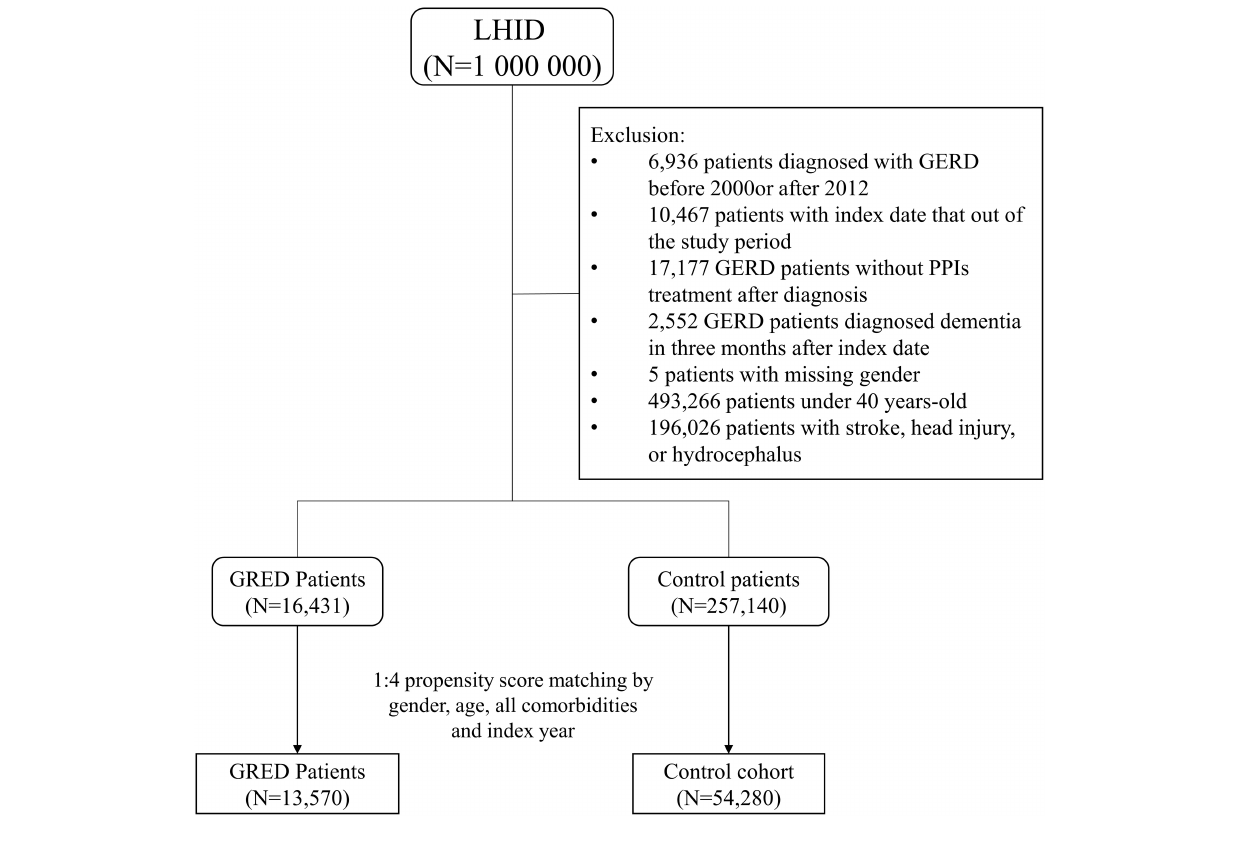
FIGURE 1 | Study flow chart of patients’